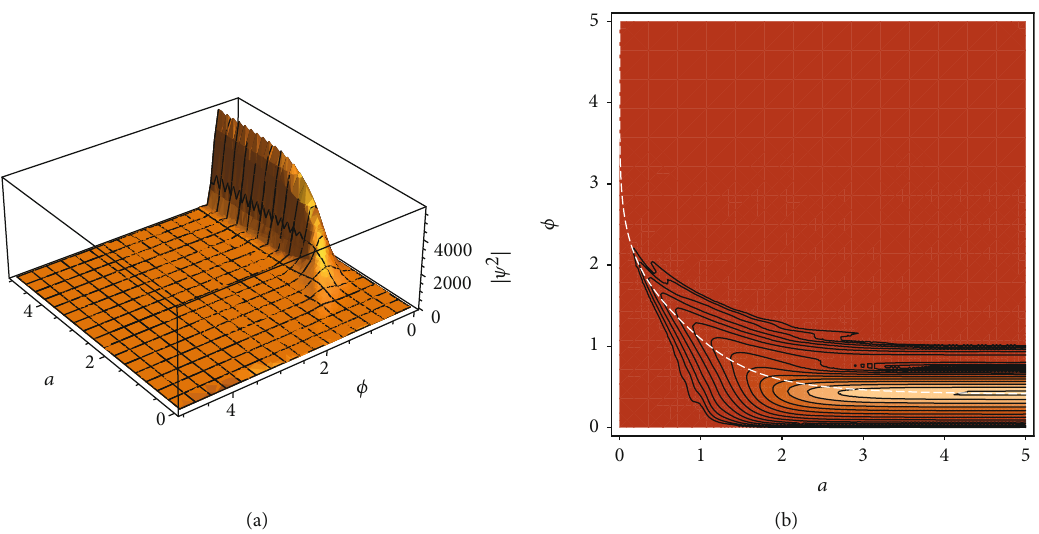
Figure 4: The fi gures show the square of the wave function (a) and its corresponding contour plot (b). Also, the dashed line denotes the classical trajectory of the system in the phase space. The fi gures are plotted for the numerical values: g Λ = 1 , λ = 1 , m = 2 , p = 0 , σ = 1/10 , and w = 1/2 0